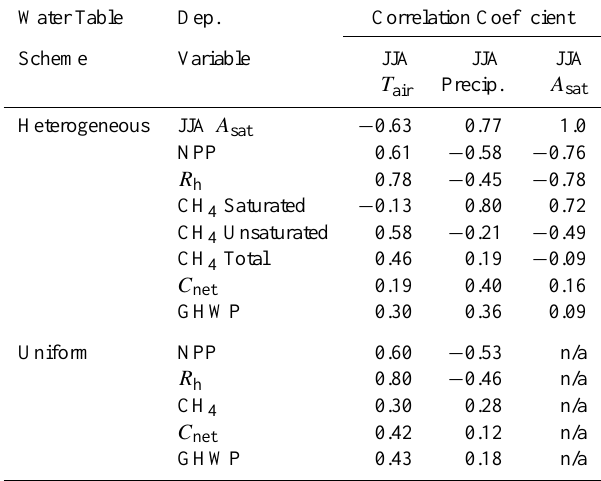
Table 6. Temporal correlations of domain-wide annual carbon fluxes with JJA hydrologic conditions over the period 1948–2010. Water Table